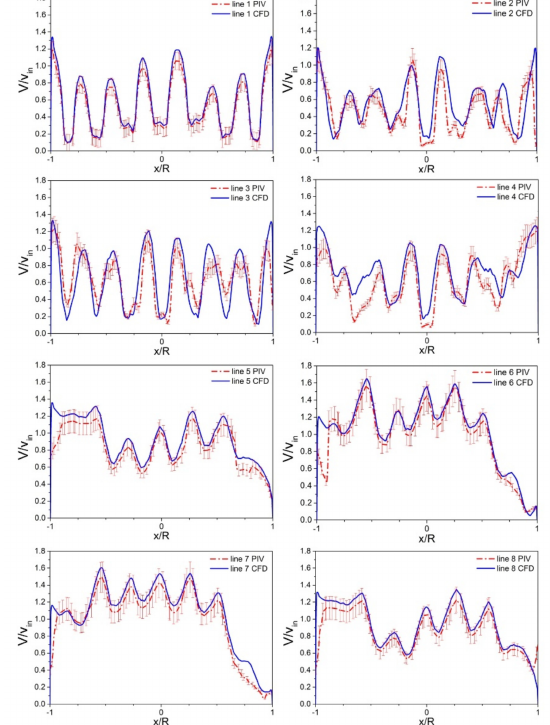
Figure 16. Comparison of velocity profiles derived by CFD method and gained from PIV for Q = 10 m 3 /